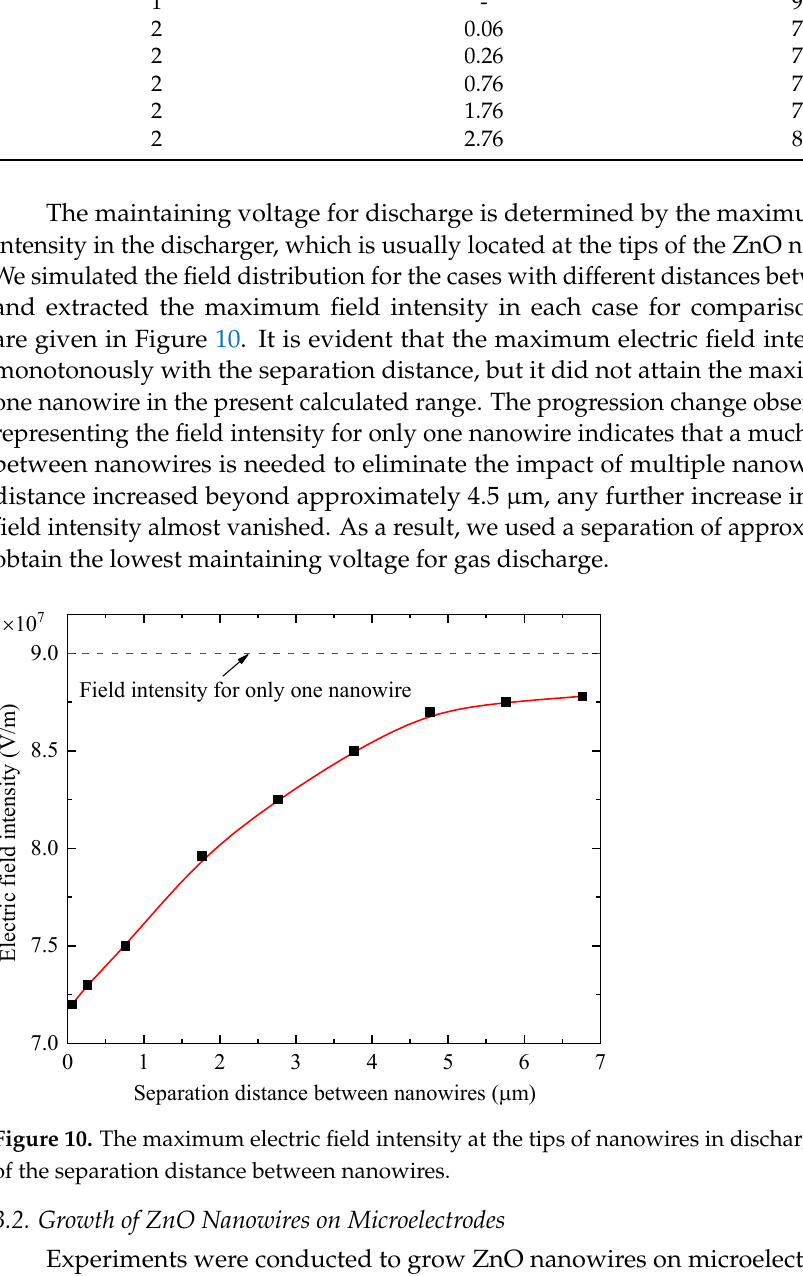
at the tips of the nanowires. 𝐸𝐸 max